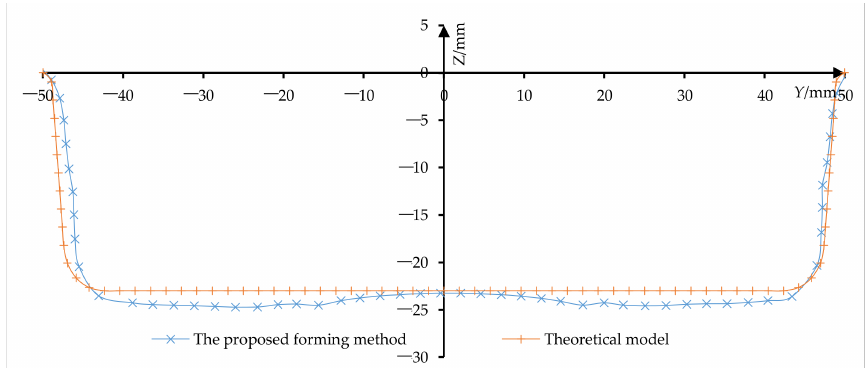
Figure 36. The profile curves.